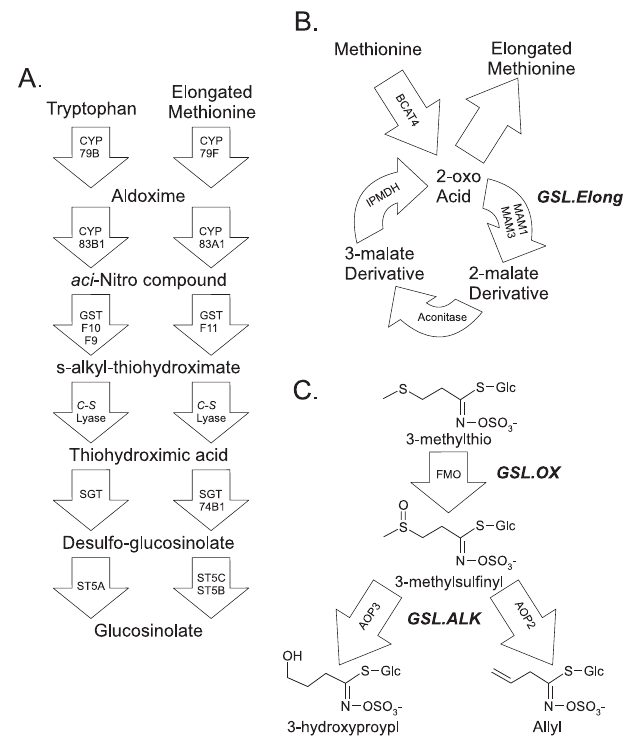
Figure 1. Glucosinolate Biosynthesis Arrows show the known and predicted steps for glucosinolate biosyn- thesis with the gene name for each biochemical reaction within the arrow. For compounds that are undetected intermediates, chemical names only are provided. For detected compounds, both the structure and chemical name are provided. The position of known genetic loci controlling biosynthetic variation is shown in italics. (A) The pathway and genes responsible for the production of the core glucosinolate structure from tryptophan (indolic glucosinolates) and methionine (aliphatic glucosinolates). (B) The chain elongation cycle for aliphatic glucosinolate production. Each cycle of these reactions adds a single carbon to a 2-oxo-acid, which is then transaminated to generate homo-methionine for aliphatic glucosinolate biosynthesis. The GSL.Elong QTL alters this cycle through variation at the MAM1 , MAM2, and MAM3 genes that leads to differential glucosinolate structure and content [32]. (C) The enzymes and genetic loci controlling aliphatic glucosinolate side chain modification within the Bay-0 3 Sha RIL population. Side-chain modification is controlled by variation at the GSL.ALK QTL via cis -eQTLs at the AOP2 and AOP3 genes. The Cvi and Sha accessions express AOP2 to produce alkenyl glucosinolates. In contrast, the L er and Bay-0 accessions express AOP3 to produce hydroxyl glucosinolates. Col-0 is null for both AOP2 and AOP3, producing only the precursor methylsulfinyl glucosino- lates [31]. The GSL.OX QTL appears to be controlled by cis -eQTLs regulating flavin-monoxygenase enzymes that oxygenate a methylthio to methylsulfinyl glucosinolate [33].